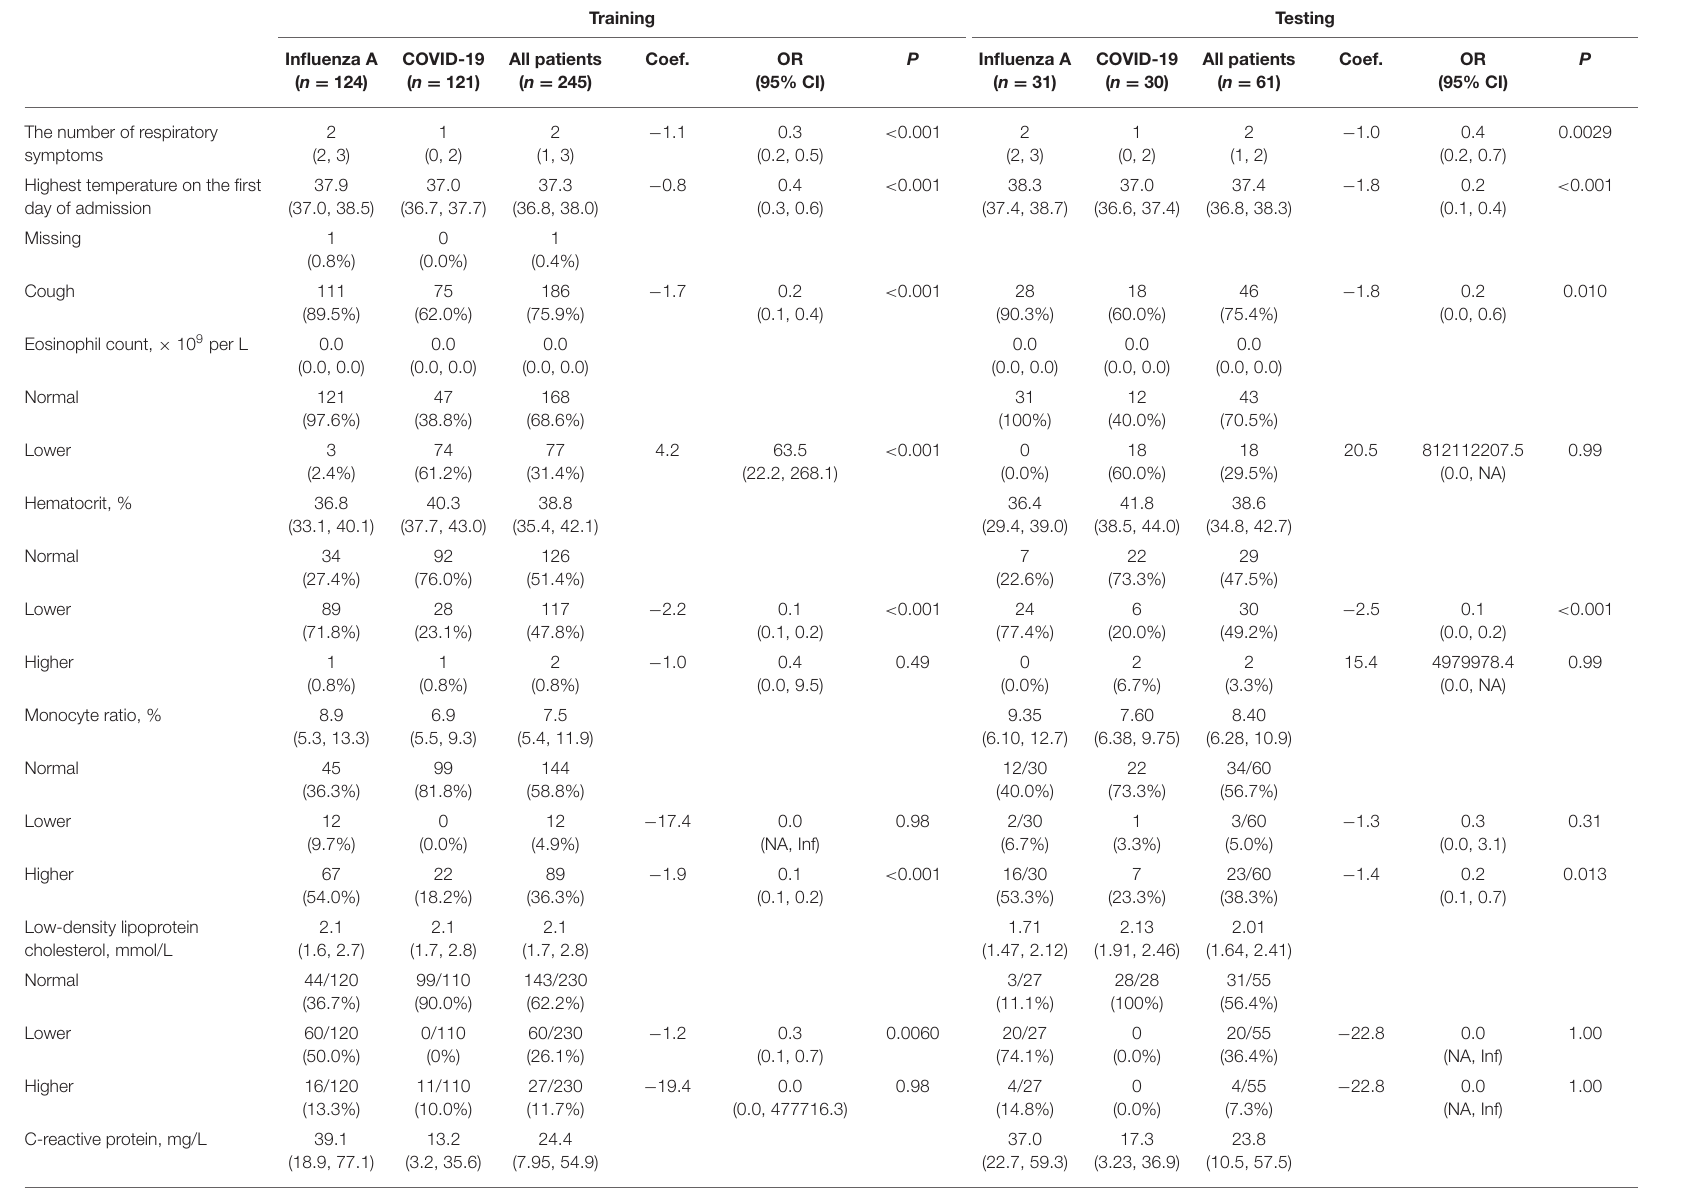
TABLE 1 | Characteristics of factors included in CART modeling, between training set and testing